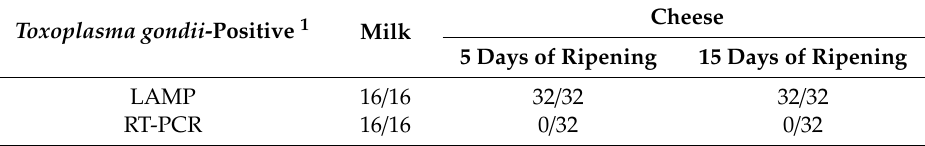
Figure 1. Chemical-physical results of raw-milk cheeses: ( a ) pH and NaCl content; ( b ) a w values. Table 1. Loop-mediated isothermal amplification (LAMP) and RT-PCR analysis of bulk milk and raw-milk cheeses obtained from ewe milk naturally infected with Toxoplasma gondii , at 5 and 15 days of ripening.